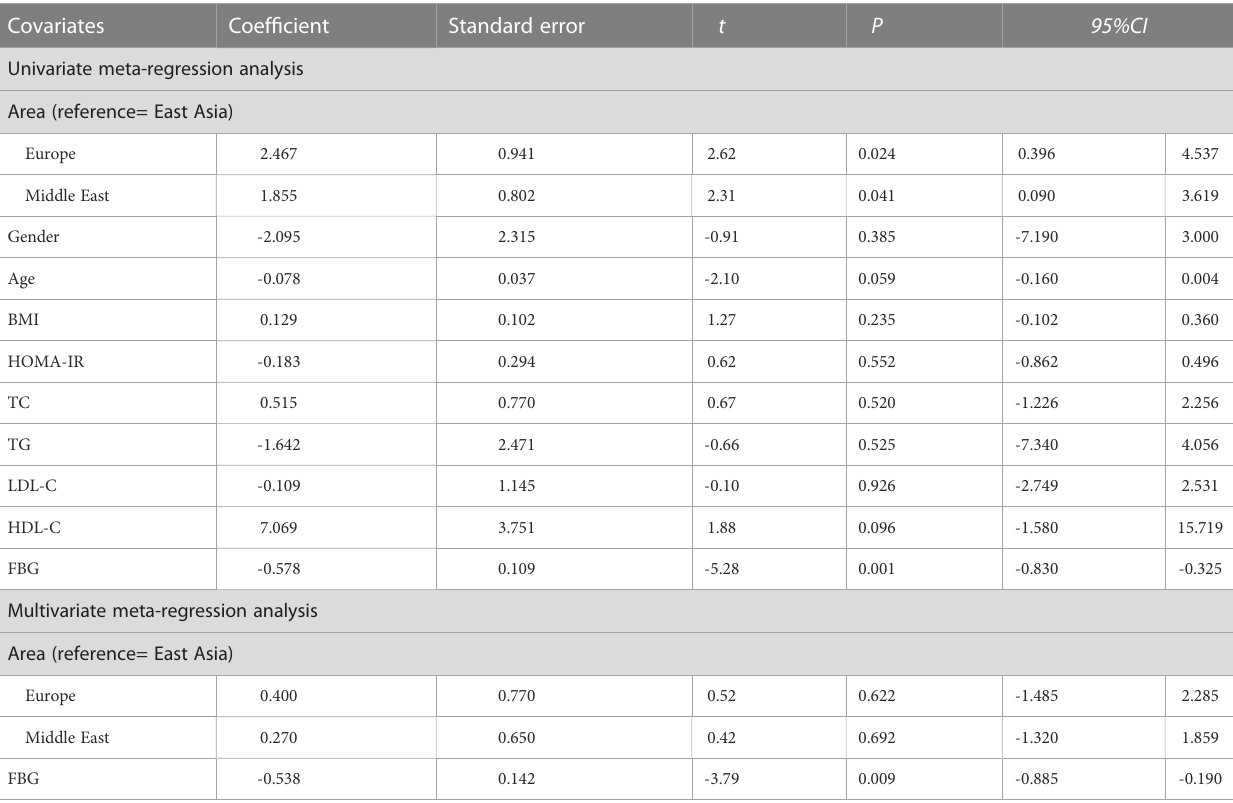
TABLE 4 Meta-regression of the circulating omentin levels and MAFLD. Covariates Coef fi cient Standard error Univariate meta-regression analysis